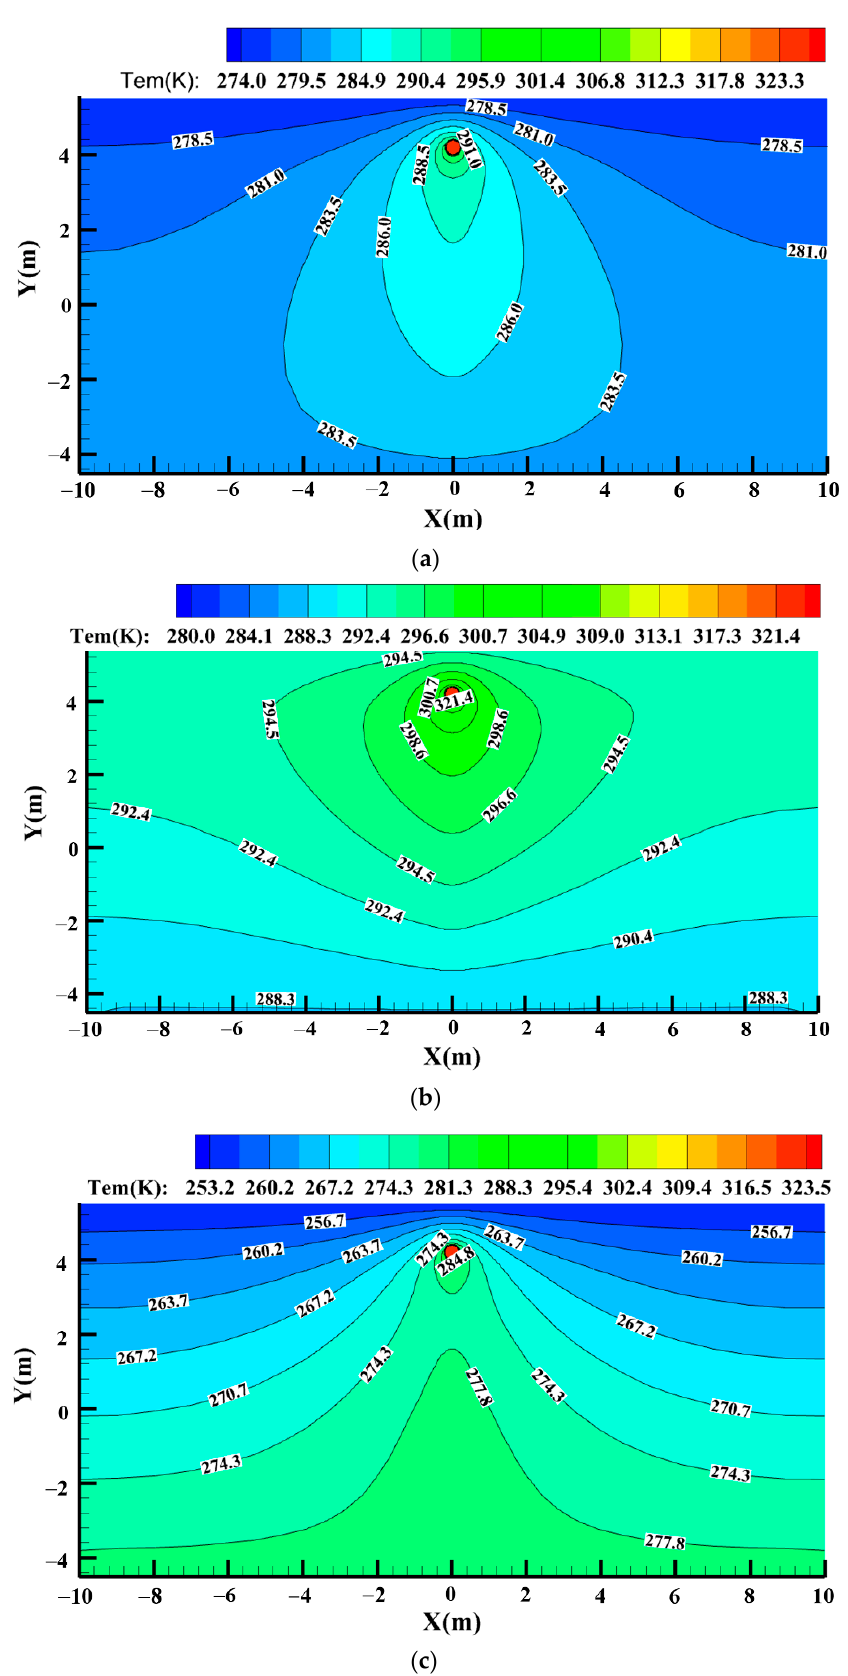
Figure 15. Temperature field in ( a ) spring or autumn, ( b ) summer, and ( c ) winter. Through the temperature distribution along the centerline on the cross section in the cases of different seasons, we further analyzed the influence of external environment on the distribution of temperature field. As can be seen from the Figure 16, the soil tempera- ture at the same position is much higher in summer than in other seasons. Except in win- ter, the temperature distribution along the centerline below the pipeline shows a trend of unilateral increase. However, in winter, the soil temperature curve beneath the pipe varies complicated, and its lowest value appears at about 0.9 m below the oil pipe. Therefore, attention should be paid to the endothermic effect of external environment on the temper- ature field of buried pipeline system in winter, and the temperature of oil flow should be appropriately raised. Figure 16. Temperature distribution along the centerline in different seasons. Figure 17 shows soil temperature distribution at a depth of 0.5 m in different seasons. In the main part of the curves, the values are close to air temperature and only rise in the range of − 2 m to 2 m along the X -axis. It indicates that the temperature at the depth of 0.5